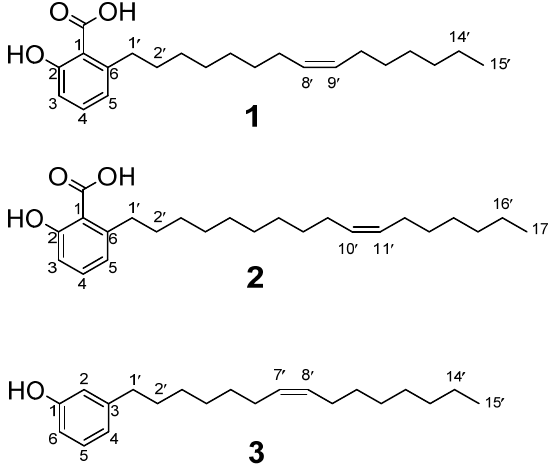
Figure 1. Structures of isolated compounds 1–3.